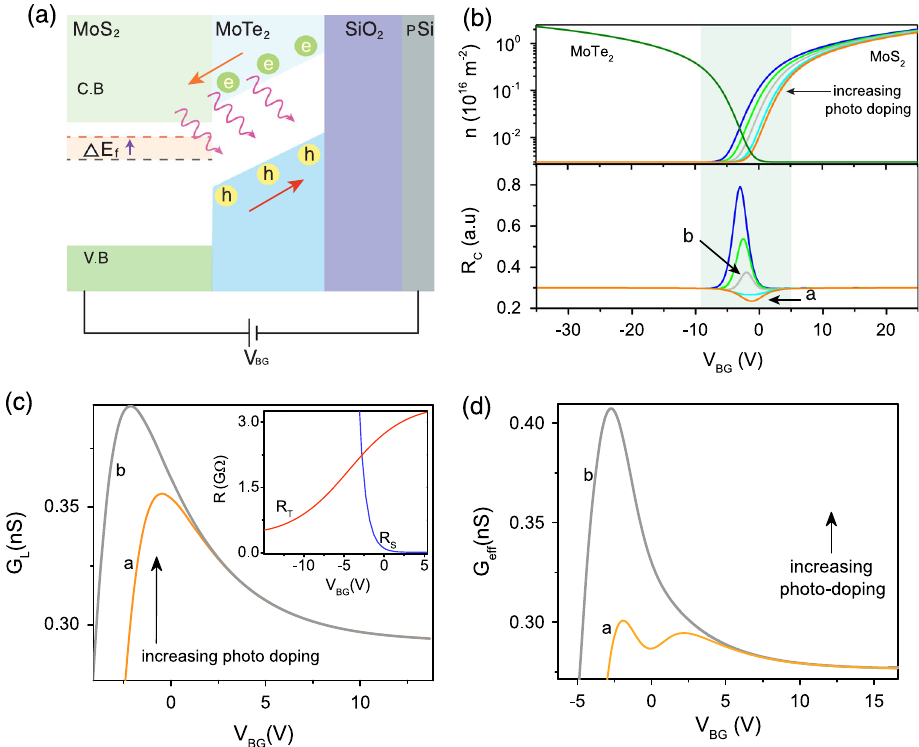
Fig. 5 a Schematic diagram of photo-induced doping process of MoS 2 and MoTe 2 fl akes. b Capacitive model to simulate effect of photo doping on the carrier concentration of individual fl akes. Upper panel shows carrier concentration ( n ) vs. V BG plot for both fl akes. For MoS 2 , n – V BG curves with different V th has been plotted considering its pronounced photo-doping effect. On the other hand, one fi xed n – V BG has been plotted for MoTe 2 , as it shows much less photo-doping effect. In the lower panel , R C – V BG graphs has been plotted for the corresponding MoS 2 n – V BG curves. The curves marked by “ a ” and “ b ” are used for G eff calculation. c G L as function of V BG for two different V th of MoS 2 corresponding to the “ a ” and “ b ” n – V BG curves. Inset shows the individual resistance R S and R T as functions of V BG . d G eff as function of V BG . As can be seen G eff captures the dip to peak